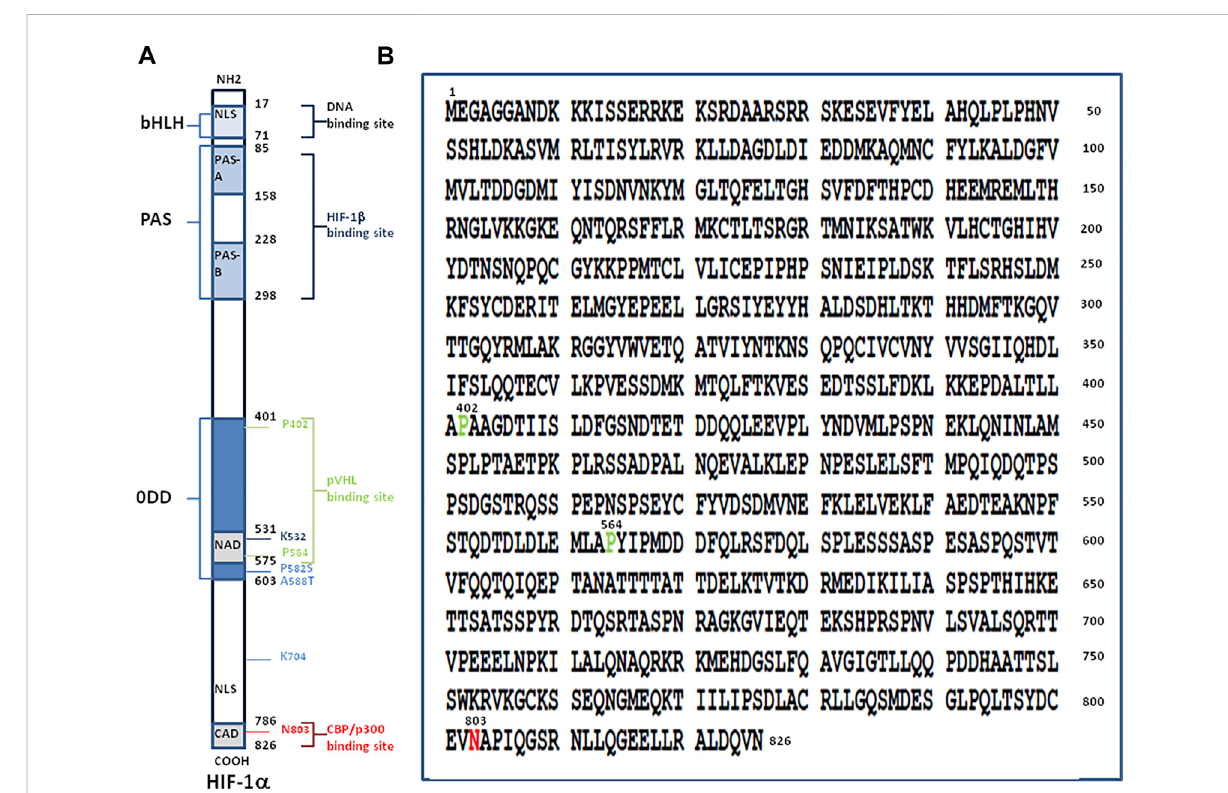
FIGURE 1 Structure of hypoxia-inducible factor, HIF-1 α . (A) Schematic representation of the HIF-1 α protein (left panel). The numbers inblack indicate the fi rst and last amino acid residues of each domain of the molecule. From the NH2-terminal to the COOH-terminal region of the protein, the main domains are:i)aN-terminal region with thebasicdomain (aa 17-30),abasic helix-loop-helixdomain (bHLH; aa 31-71)composedoftwoamphipatic α -helicesconnectedbyaloop,andanuclearlocalisationsignal(NLS;aa17-74);ii)aPer-AHR-ARNT-Simhomologydomains(PASincludingthe PAS-A aa 85-158, and PAS-B aa 228-298) involved in heterodimerisation with HIF-1 β ; iii) an oxygen-dependent degradation domain (ODD; aa 401- 603)whichcontainstwoPEST-likemotifs(aa499-518and581-600)richinproline(P),glutamicacid (E) ,serine(S)andthreonine(T)(notshown);iv)a transactivation domains (TADs also termed NAD aa 531-575 and CAD aa 786-826) with the conserved residues 792-796 making contacts with the surface zinc-binding TAZ1 domain of CBP; and v) a C-terminal NLS (aa 718-721). Prolines P-402 and P-564 within the ODD and asparagine N-803 within CAD are requires for the full activation of HIF-1 α . Under normoxic conditions the N-803 is hydoxylated by the FIH-1 hydroxylase and P-402 and P-564 within the ODD are hydroxylated by the prolyl hydroxylase PHD and the hydroxyproline residues become buried within the hydrophobic core of pVHL leading to ubiquitinylation of HIF-1 α . The HIF-1 α proteinstability isincreased byacetylation on lysine K-709as well as by proline P-582 substitution (P582S) and alanine A-588 substitution (A588T). Acetylation of lysine K-532 promotes interaction with and ubiquitination by pVHL.